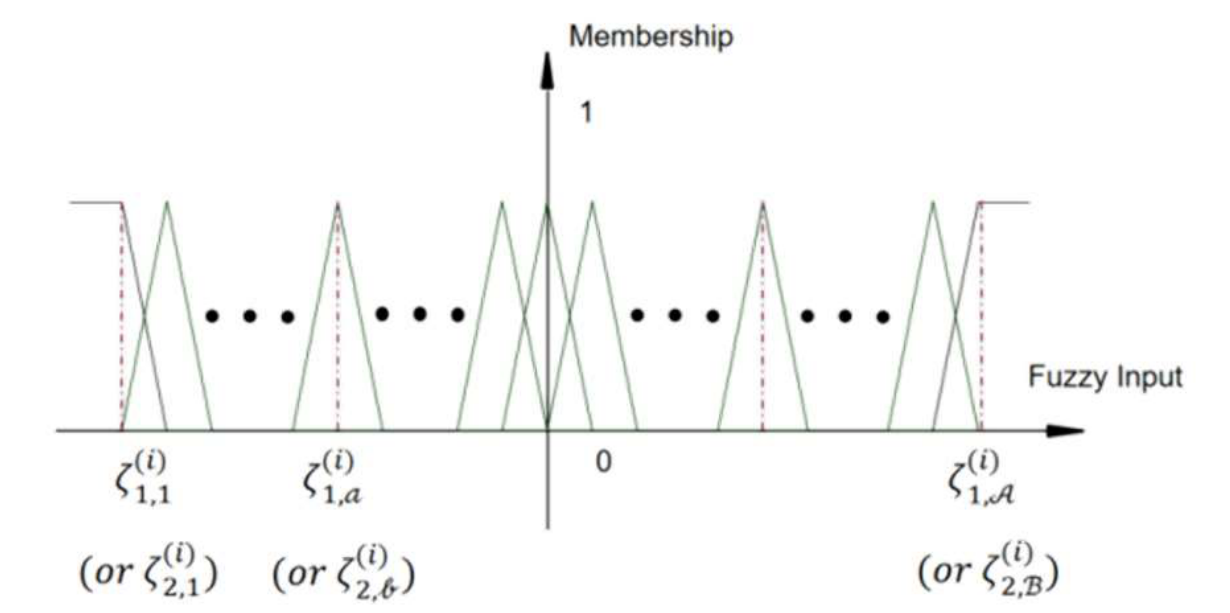
(cid:3047)(cid:3035) subsystem.